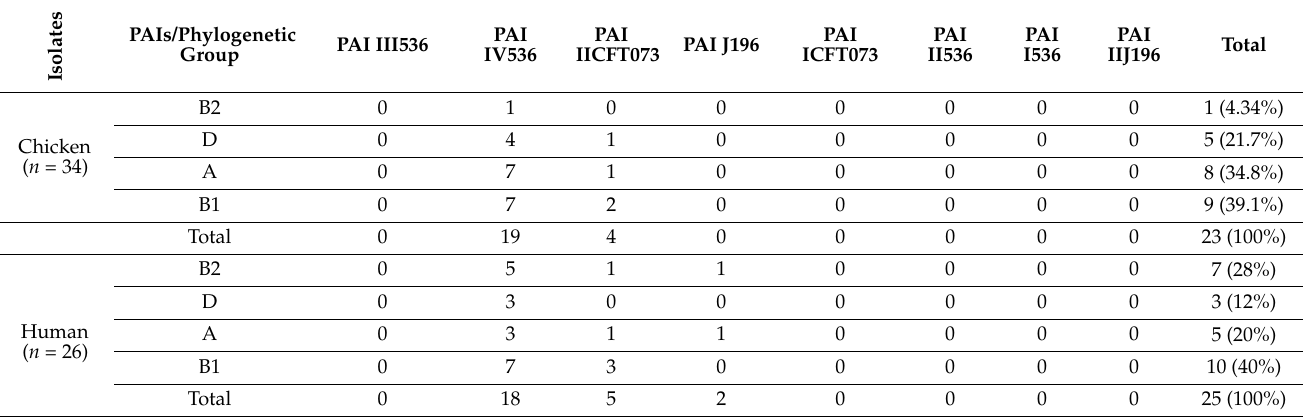
Table 3. Distribution of pathogenicity islands (PAIs) among E. coli isolates in relation to phylogenetic